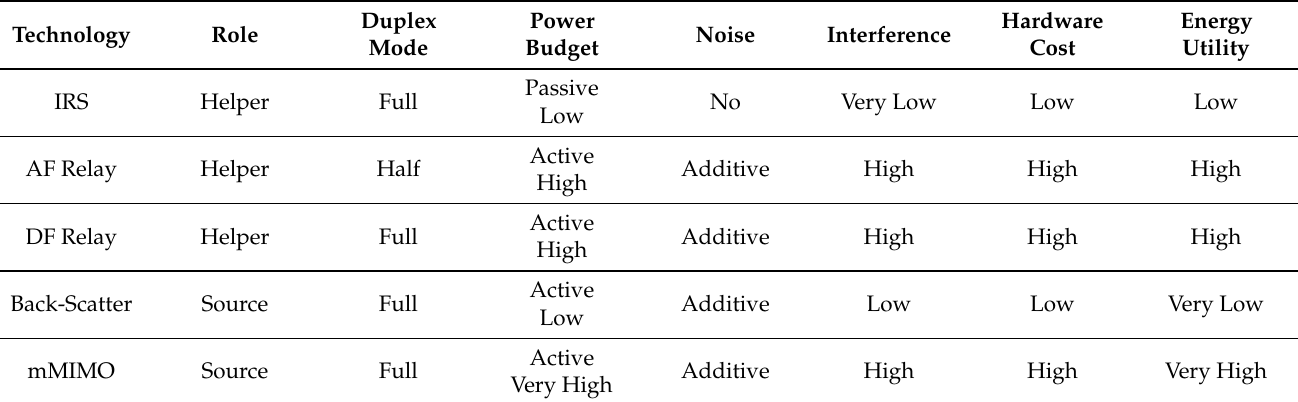
Table 3. Comparison of IRS with Other Related